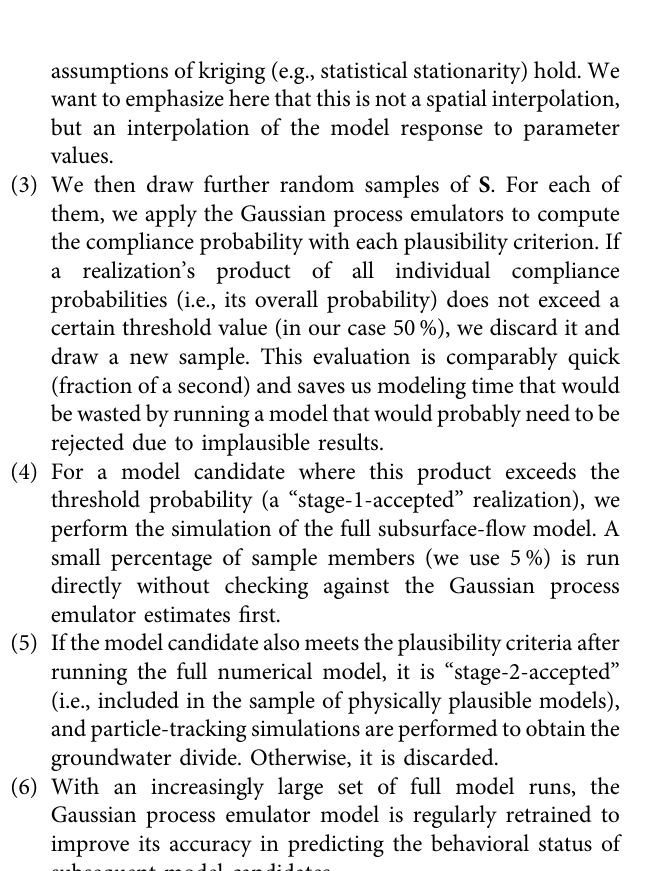
Frontiers in Earth Science |